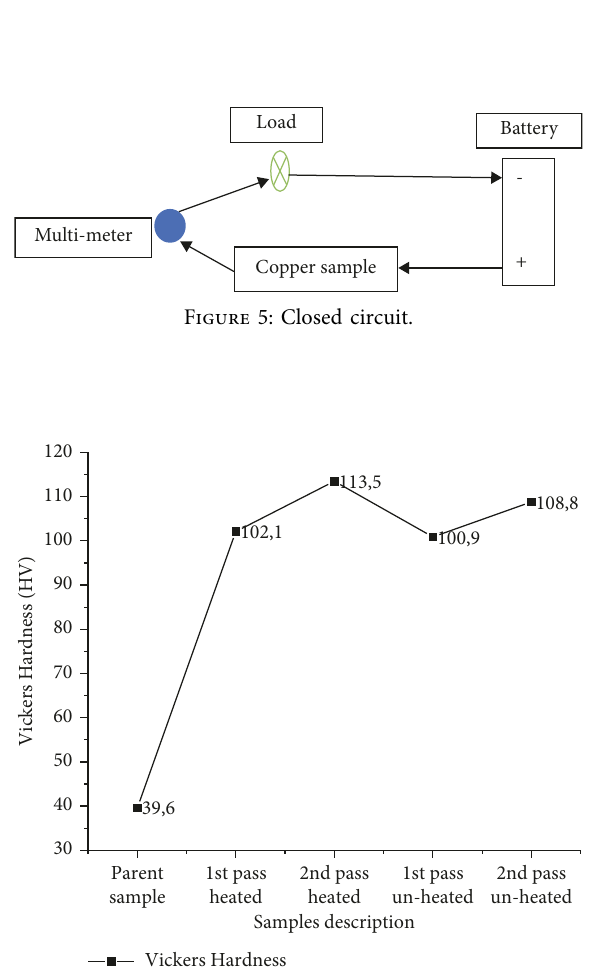
Figure 6: Vickers hardness of unheated and heated ARB samples.